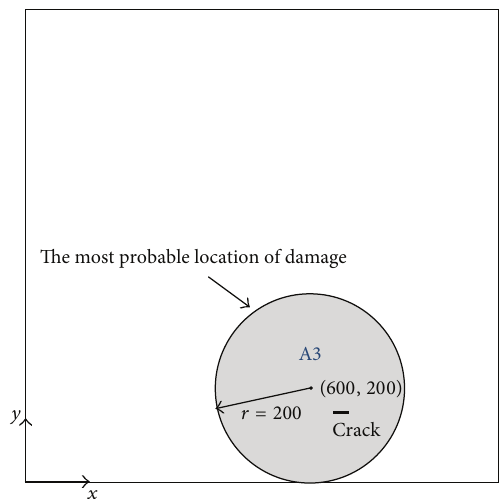
Figure 10: Signal acquisition locations for identifying a through- thickness crack in aluminum plate (unit: mm).